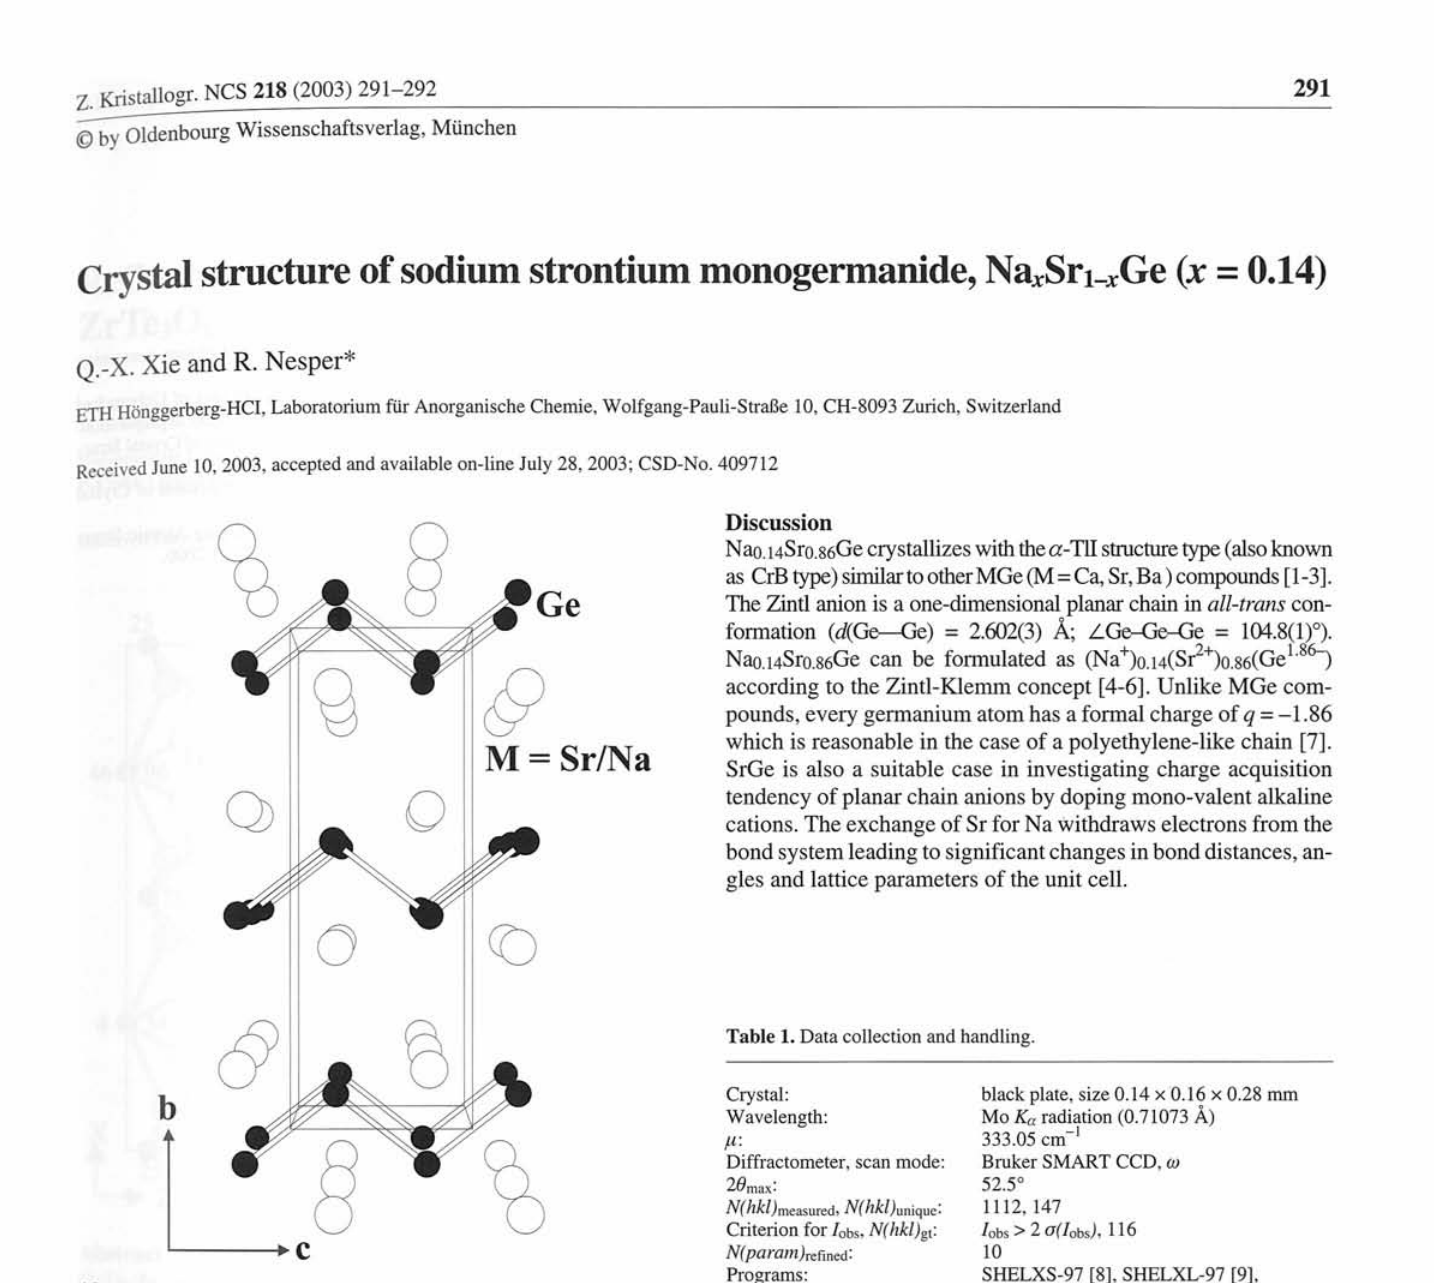
Table 1. Data collection and handling.